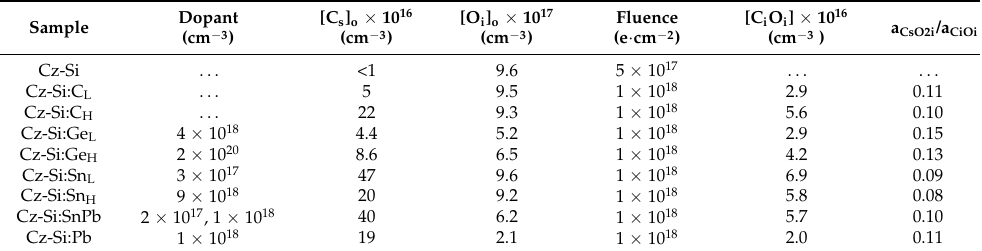
Figure 17. The production of C i O i defect as a function of isovalent dopant covalent radius. Repro- duced with permission from [155]. American Institute of Physics, 2013. Table 5. Initial concentrations of O i and C s , as well as those of VO, C i O i concentrations and the ratio a CsO2i/aCiOi for the samples used, irradiated with 2 MeV electrons at various fluencies [155].